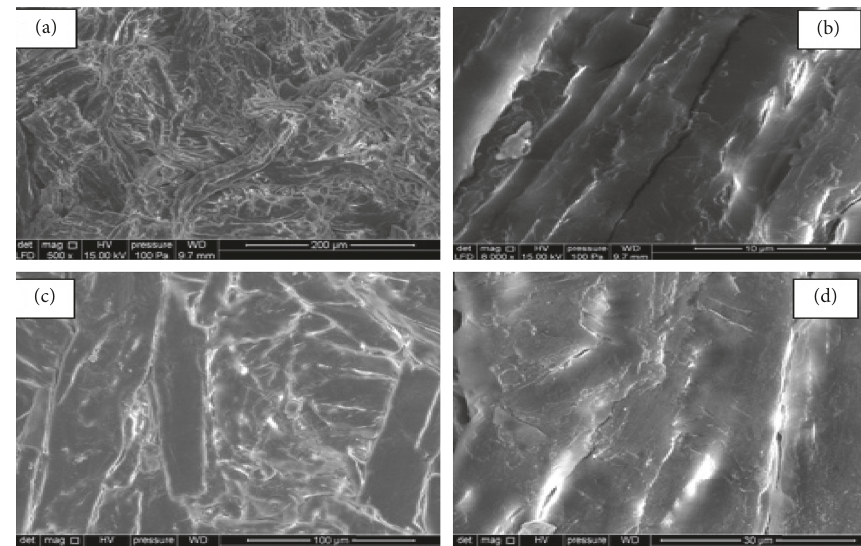
Figure 3: (a, b) Characterization of red sawdust by scanning electron microscopy. (c, d) Characterization of catia sawdust by scanning electron microscopy.